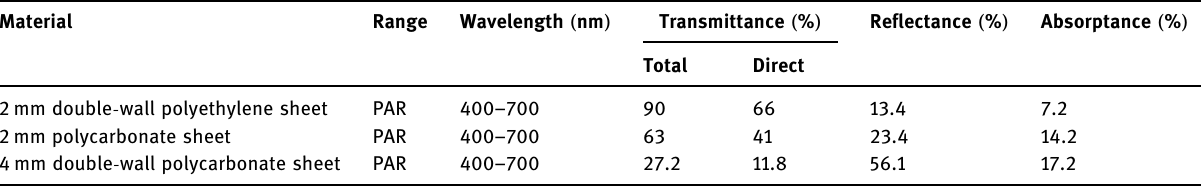
Table 4: Spectral analysis of the covering materials as reported by Hochmuth ( 1993 ) and Subin et al. ( 2018 ) Material